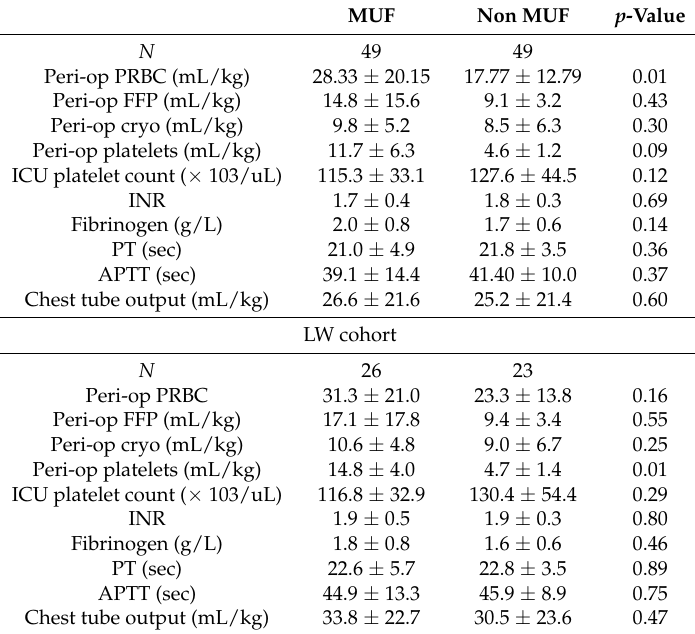
Table 5. Transfusion data, post-op labs, and chest tube